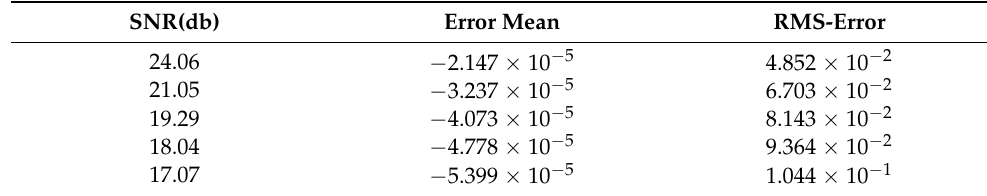
Table 2. Error at different